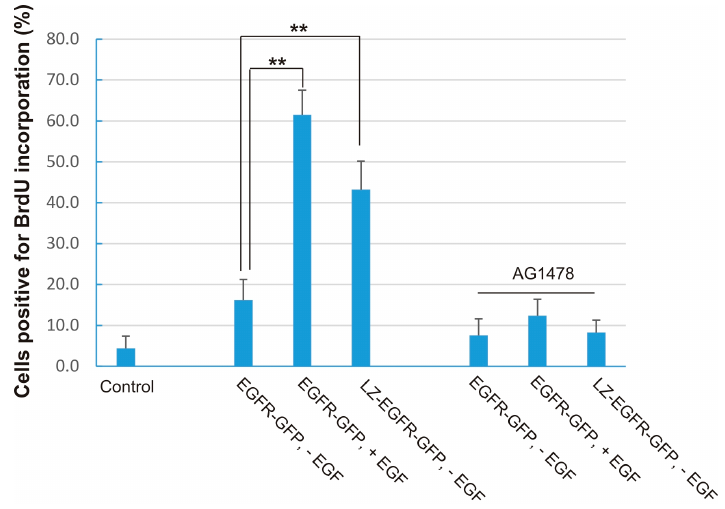
Figure 8. Stimulation of DNA synthesis by LZ-EGFR-GFP. 293T cells were transiently transfected with EGFR-GFP or LZ-EGFR-GFP. Following serum starvation for 24 h, cells were treated with EGF and/or AG1478 as indicated. DNA synthesis was determined by BrdU incorporation as described